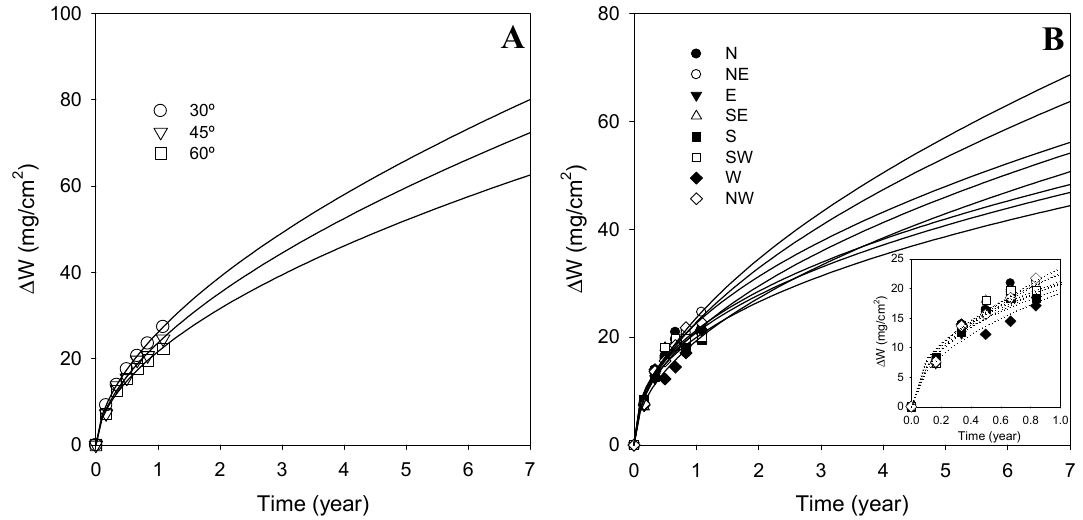
Figure 2. Weight loss of carbon steel as a function of time for panels exposed with varying: ( A ) exposure angles with respect to the horizontal, and ( B ) orientations.